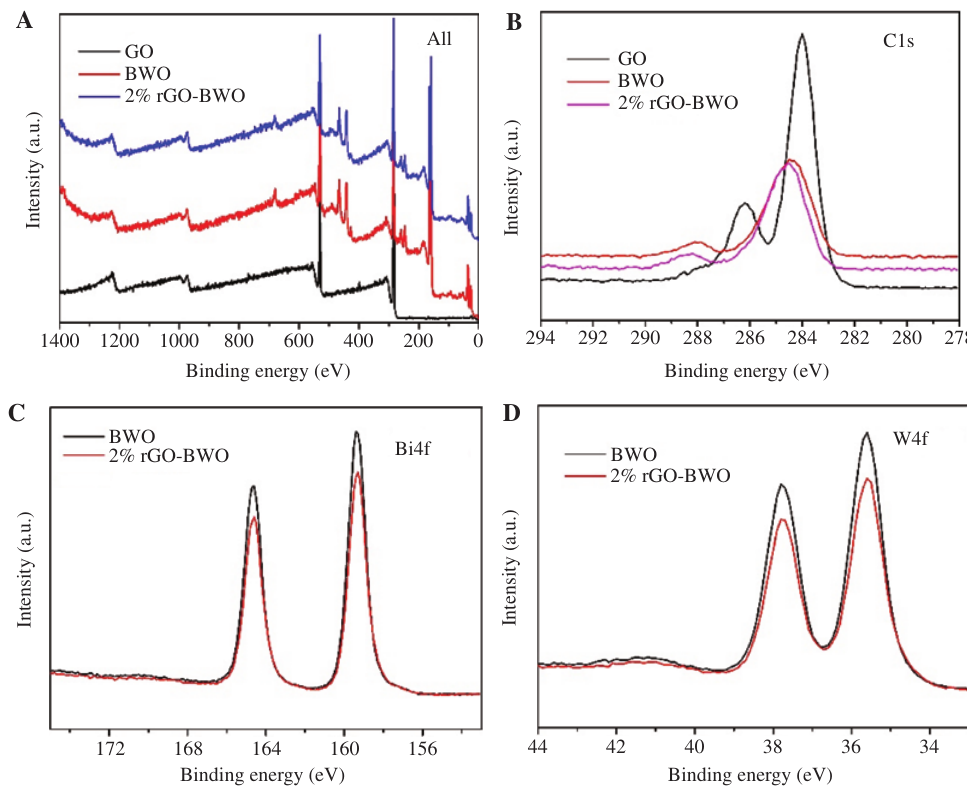
Figure 5: XPS spectra of GO, BWO and rGO-BWO samples: (A) survey, (B) C1s, (C) Bi4f, (D) W4f.